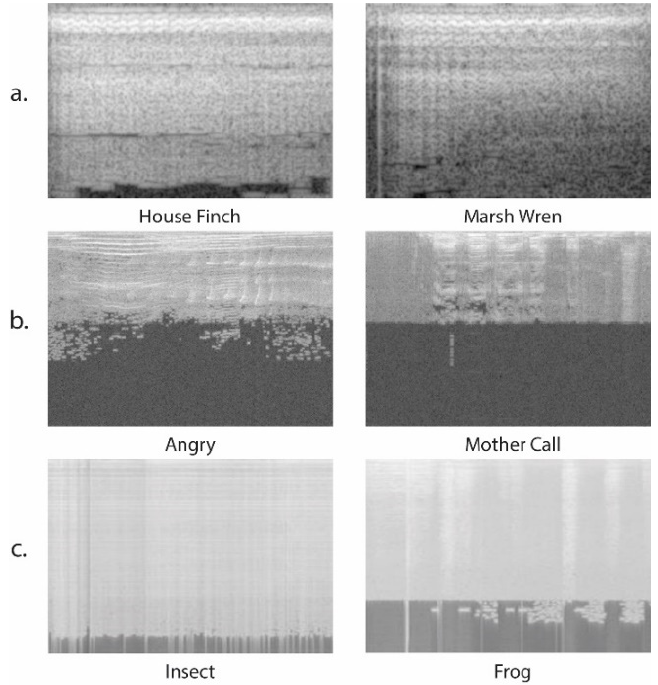
Figure 4. Spectrogram samples from ( a ) BIRDZ, ( b ) CAT, and ( c ) ESC-50 illustrating the applications of identifying bird songs, cat calls, and environmental noise. The horizontal axis in each image represents time, and the vertical axis represents frequency. Note that the frequency scale has been reversed in this figure.